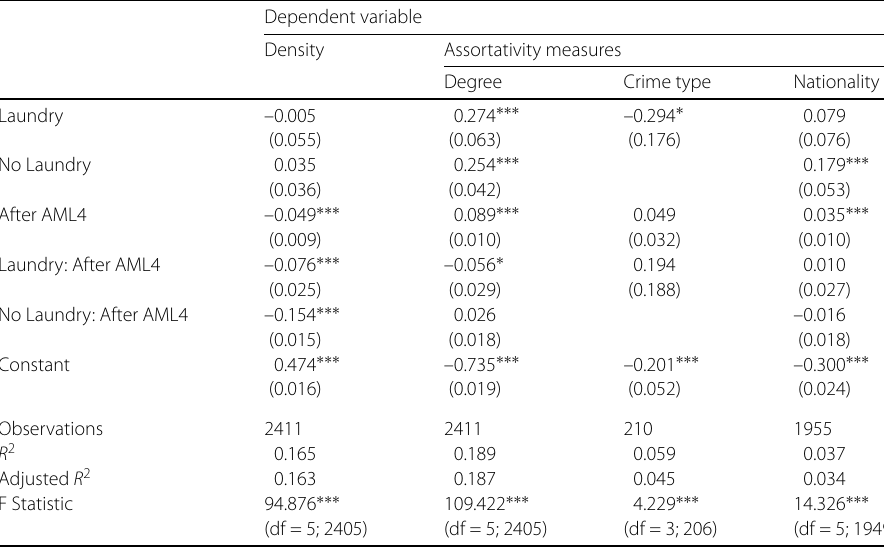
Table 6 Results of random effect regressions on cluster connections Dependent variable Density Assortativity measures Degree Crime type